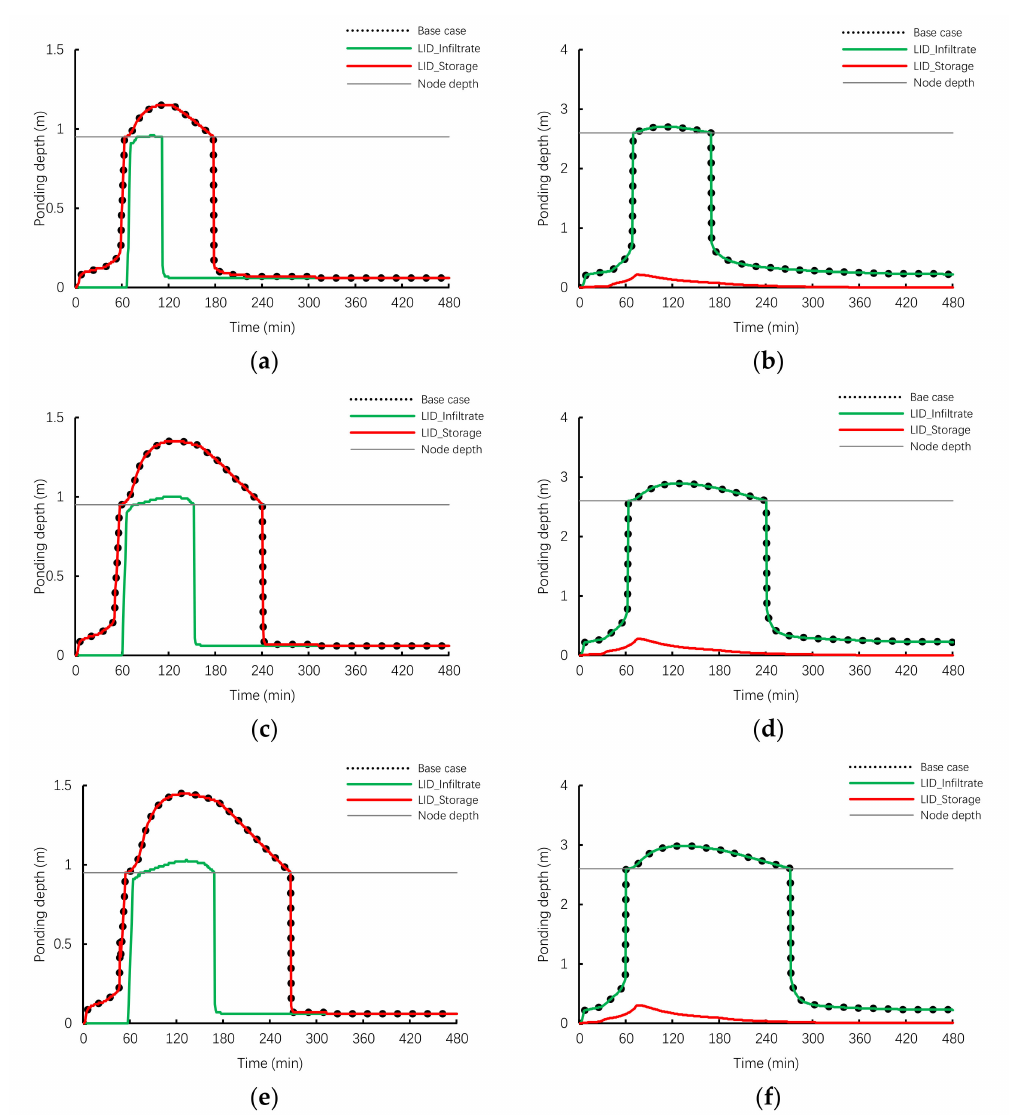
Figure 7. Ponding time of various LID scenarios when rainfall duration is 180 min: ( a ) When return period is 1a, ponding time at node 47; ( b ) When return period is 1a, ponding time at node 52; ( c ) When return period is 3a, ponding time at node 47; ( d ) When return period is 3a, ponding time at node 52; ( e ) When return period is 5a, ponding time at node 47; ( f ) When return period is 5a, ponding time at node